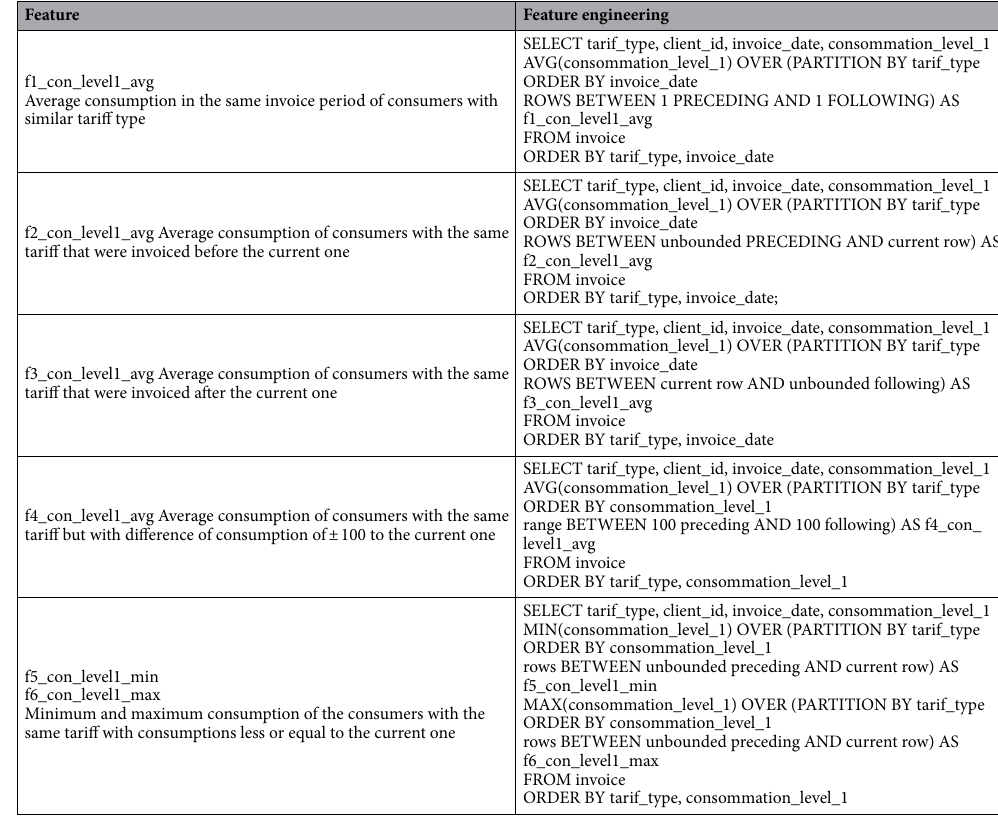
Table 2. Example of feature engineering with SQL analytic